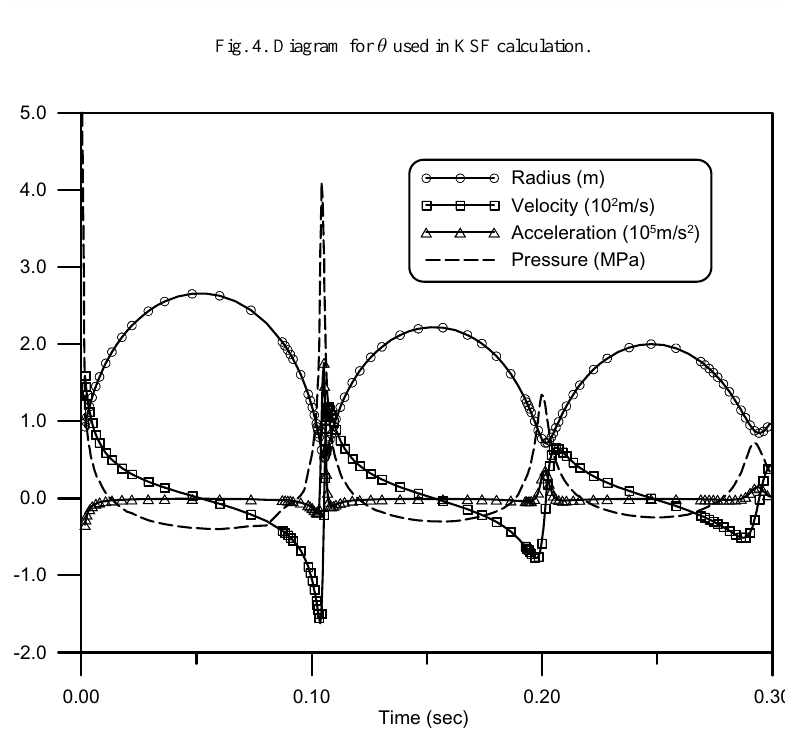
Fig. 5. Bubble motion